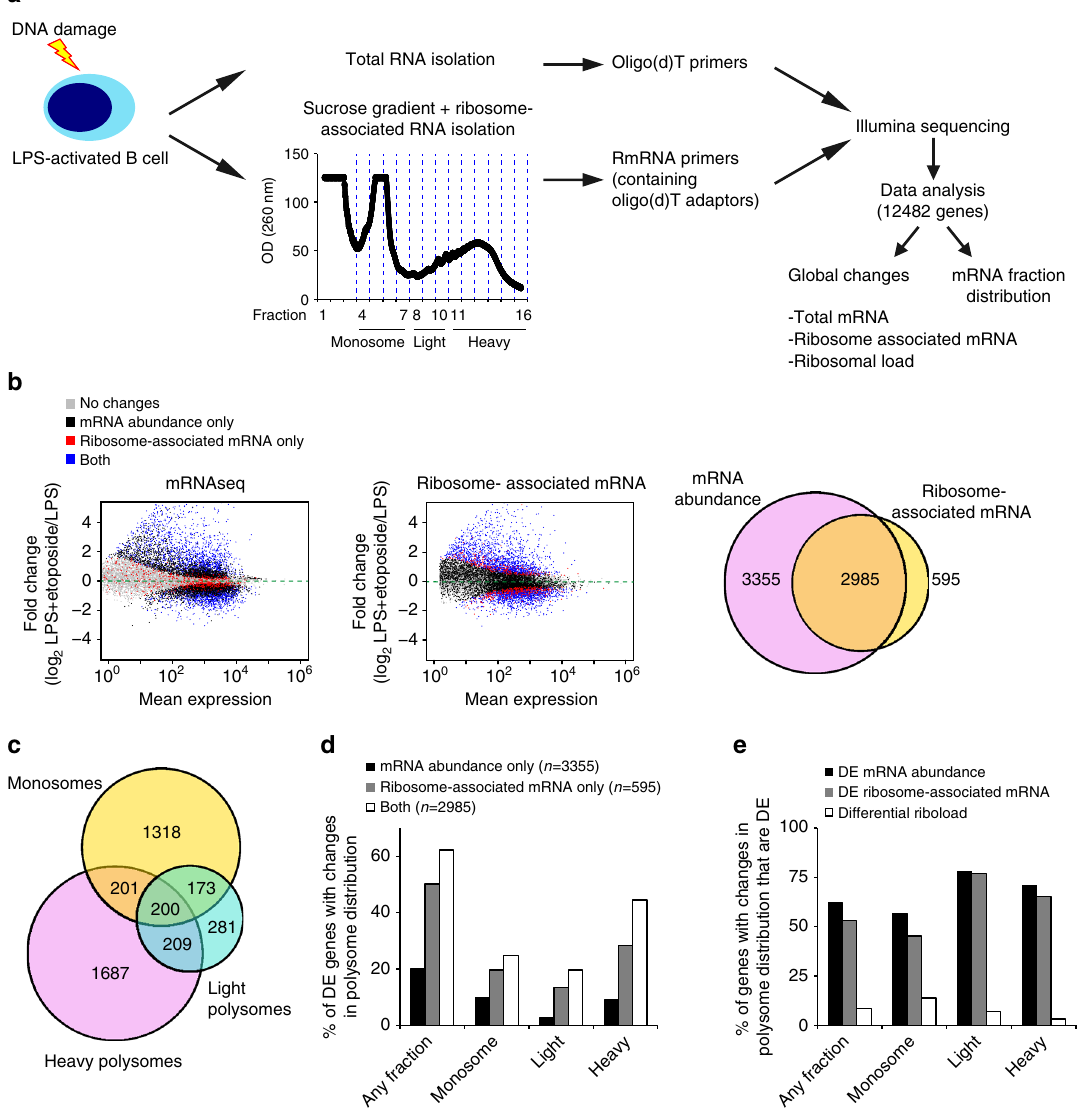
Fig. 2 DNA damage induces changes in mRNA translation decoupled from total mRNA abundance. a Experimental set up for the study of etoposide- induced changes in total mRNA abundance (mRNAseq) and mRNA translation (Polyribosome pro fi ling followed by 3 ′ end RNA sequencing; PolyRibo-3 ′ RNA-seq) in B cells. Libraries from four biological replicates were generated for both mRNAseq and PolyRibo-3 ′ RNA-seq. Changes in total cellular mRNA abundance, changes in ribosome-associated mRNAs and changes in polysome distribution after induction of DNA damage were analyzed using DESeq2 (transcripts collapsed by gene id). b Visualization as MA plots of changes in B-cell transcriptome and B-cell translatome after etoposide treatment (20 μ M, 4 h) (LPS = L, LPS + Etoposide = LE). Top panel , MA plot showing the mean expression of mRNA transcripts in B cells vs. changes in total mRNA abundance after treatment with etoposide (mRNAseq). Middle panel , MA plot showing the mean abundance of ribosome- associated mRNAs vs. changes in mRNA translation induced by etoposide (PolyRibo-3 ′ RNA-seq) ( grey — unchanged mRNAs in both datasets, black — mRNAs that change in cellular mRNA abundance only, red — mRNAs with a translational change only, blue — mRNAs that change at both mRNA abundance and translation). Bottom panel , Venn-diagram with the number of mRNAs that change in abundance, translation or both. c Venn-diagram showing the number of mRNA transcripts with signi fi cant changes in monosome, light and heavy polysome fractions (mRNA fraction distribution analysis). d Proportion of differentially expressed (DE) mRNAs, differentially ribosome-associated mRNAs or both that show a signi fi cant change in polysome distribution. mRNAs are grouped based on signi fi cant changes in abundance in any of the fractions (fractions 4 to 16) or in monosomes only (fractions 4 to 7), in light polysomes (fractions 8 to 10) or in heavy polysomes (fractions 11 to16). e Proportion of genes with a change in polysome distribution (de fi ned change in any of the fractions, monosomes, light polysomes and heavy polysomes) that are differentially expressed (DE, change in total mRNA abundance), differentially associated with ribosomes or show a change in RiboLoad (de fi ned as the proportion of reads in heavy polysomes divided by the total of reads mapped to a given mRNA transcript; [LPS + Etoposide vs. LPS and 0.75 < RiboLoad < 1.25]) Tia1 binding to p53 3 ′ UTR controls mRNA translation . Tia1 transcriptional control of p53 mRNA translation by Tia1 might be is a regulatory mechanism in activated B cells that is respon- has been implicated in mRNA subcellular location and transla- sible for changes in gene expression during the DNA damage tional silencing 25, 29 , therefore we hypothesized that Tia1 was responsible for p53 translational control in B lymphocytes. iCLIP response. NATURE COMMUNICATIONS | 8: 530 | DOI: 10.1038/s41467-017-00454-2 |